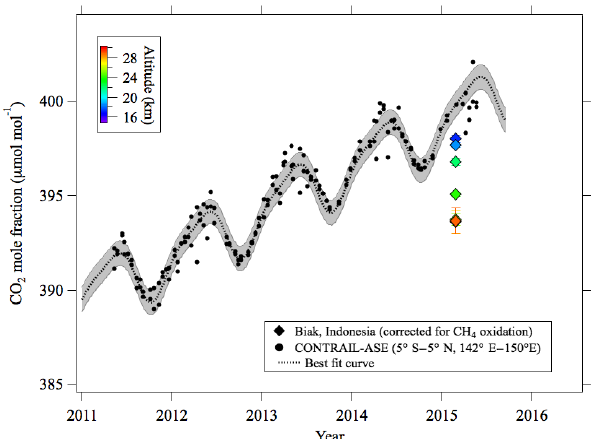
Figure 4. Stratospheric CO 2 mole fraction values observed over Biak and tropical upper tropospheric data (5 ◦ N–5 ◦ S, 142–150 ◦ E; 10–12.5km) obtained by the CONTRAIL aircraft project. Also shown is the best fit curve fitted to the CONTRAIL data. The gray shading shows 1 standard deviation width calculated by using the fitting